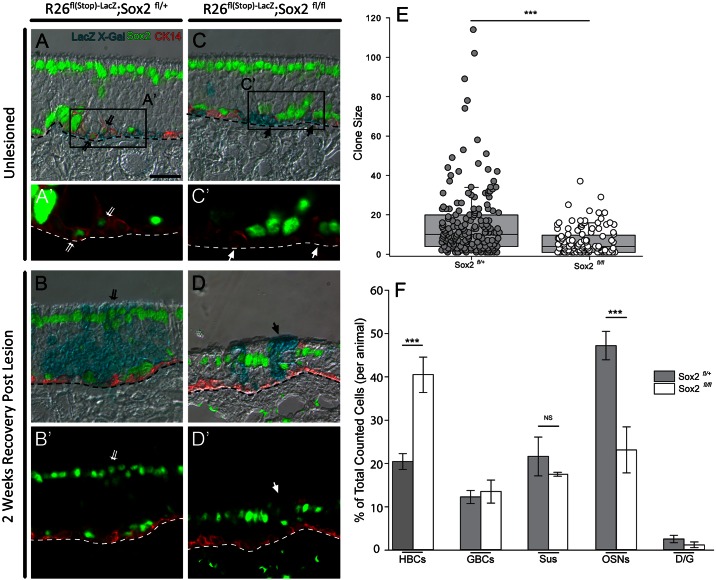
CreERT2-mediated excision of Sox2 in HBCs reduces clone size and neuron numbers.Tamoxifen was administered to unlesioned (A) and lesioned (B) control K5CreERT2; Sox2flox/+; R26fl(stop)-LacZ mice, as well as to unlesioned (C) and lesioned (D) experimental K5CreERT2; Sox2flox/flox; R26fl(stop)-LacZ mice; tissue was analyzed three weeks into epithelial recovery. Sections are X-gal-stained to detect β-galactosidase activity within clones, stained for cytokeratin 14 to mark HBCs, and immunolabeled for Sox2 to confirm gene recombination. (A) In the mice that are heterozygous for the floxed Sox2 allele, the excision of one copy of Sox2 had no discernable effect in the absence of lesion. (A’) The inset shows Sox2 labeling in β-galactosidase-marked CK14 (+) basal cells, as expected (double thin arrows). (B, B’) In the heterozygous animals, excision of one copy of Sox2 had no effect on the composition of the clones that arise following MeBr-lesion from the activated HBCs. X-gal-labeled Sus cells maintain their prominent expression of Sox2 following their regeneration from the HBCs that have undergone genetic recombination, as expected (double thin arrows). (C) In the unlesioned, homozygous floxed Sox2 mice, the absence of Sox2 has no apparent effect. (C’) The inset shows the absence of Sox2 labeling in β-galactosidase-marked CK14 (+) basal cells, as expected (single arrows). (D, D’) However, when the Tamoxifen-treated, homozygous floxed-Sox2 mice were exposed to MeBr, the X-gal-stained clones resulting from lesion-induced activation of the HBCs were smaller and contained fewer neurons. X-gal-labeled Sus cells lack their usual prominent expression of Sox2 following their regeneration from the HBCs that have undergone genetic recombination, as expected (single arrows). (E) Comparing lesioned tissue between floxed Sox2 homozygotes and heterozygotes, the range in the number of cells/clone is depicted in the form of a box-and-whiskers scatter plot, and the median clone size is indicated by the horizontal black line within the box. The median value of clone size between heterozygote vs. homozygote is 10 vs. 4, respectively. The difference between homozygotes and heterozygotes is statistically significant (Mann-Whitney U test, *** p < 0.001). (F) Compositional analysis plotting the relative number of different cell types in each clone, reveals that the percentage of neurons (OSNs) is significantly decreased in the floxed Sox2 homozygotes (white bars) compared to heterozygotes (black bars) (Mann-Whitney U-test, *** p < 0.001), while the percentage of HBCs is increased (Mann-Whitney U-test, *** p < 0.001). Scale bar in A is 25 μm and applies to all panels except A’ and C’. The dashed lines mark the basal lamina.